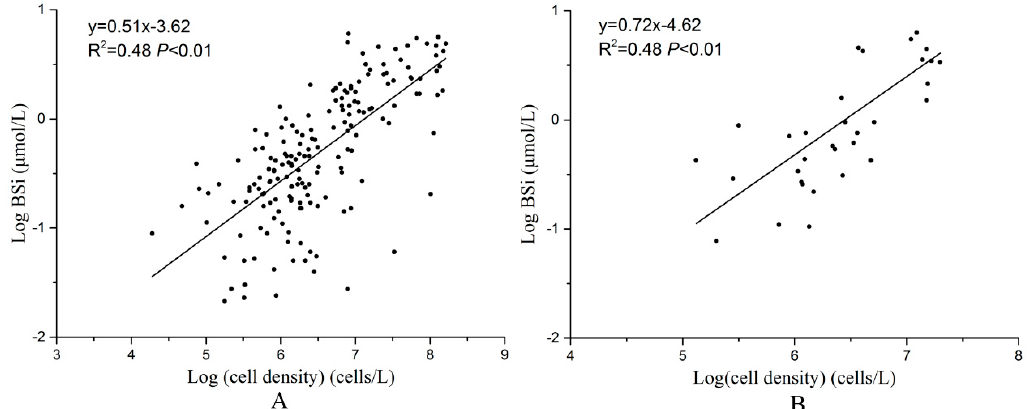
Figure 5. Relationships between diatom cell density and DSi in the lacustrine zone ( A ) and riverine zone ( B ).